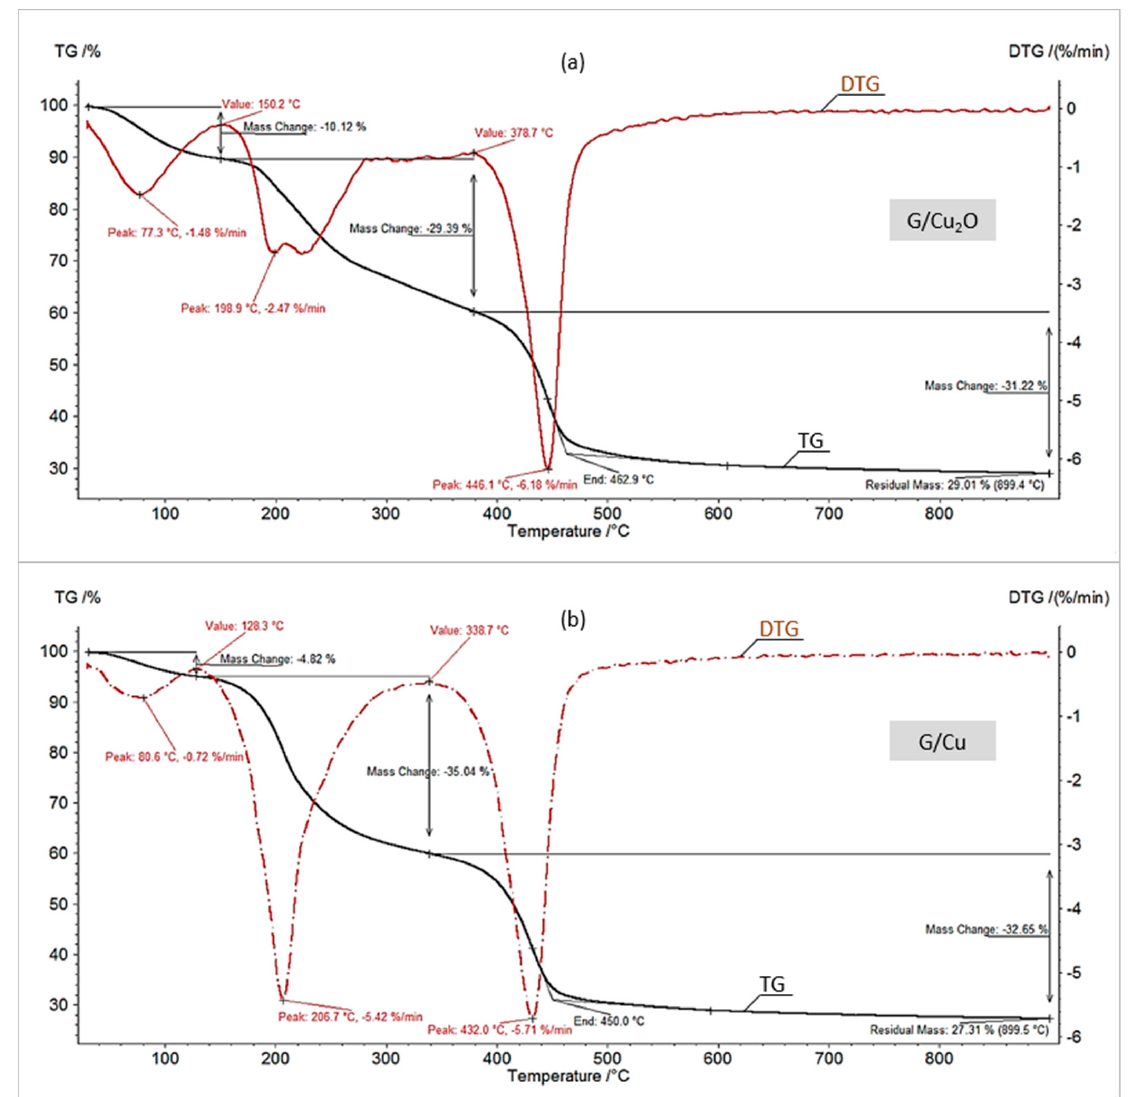
Figure 5. TG/DTG curves in N 2 of ( a ) G/Cu 2 O, ( b ) G/Cu.